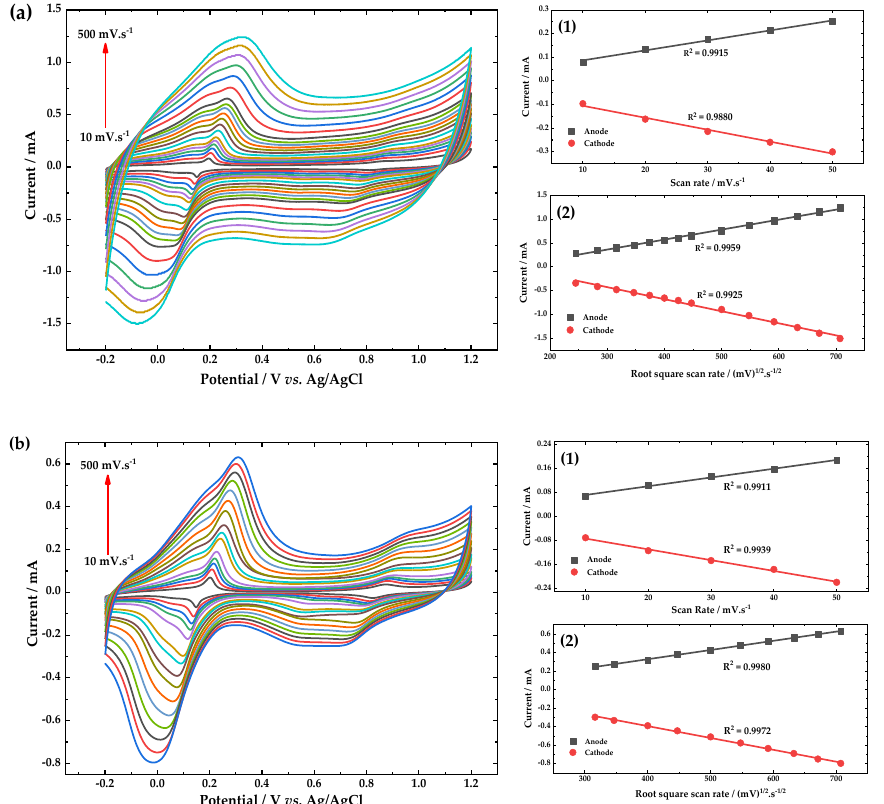
Figure 8. Cyclic voltammograms response of the ( a ) PB / fCNTs / GC and ( b ) PB / ZrO 2 -fCNTs / GC modified electrodes, in a 0.1 mol · L − 1 PBS (pH 6.8) solution, at scan rates between 10–500 mV · s − 1 . Inset ( 1 ) current vs. scan rate, and inset ( 2 ) current vs. (scan rate) 1 / 2